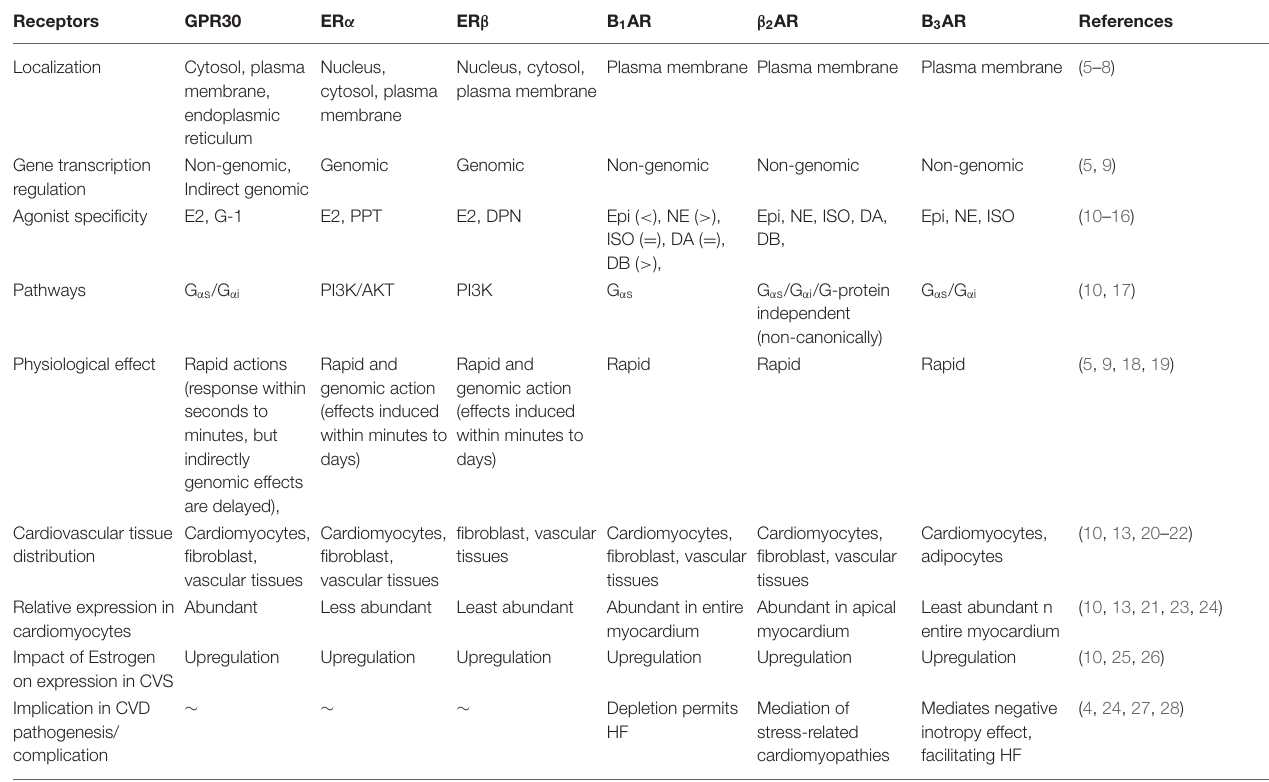
TABLE 1 | Characteristics and activities of estrogen receptors (ERs) and β -adrenergic receptors ( β ARs).